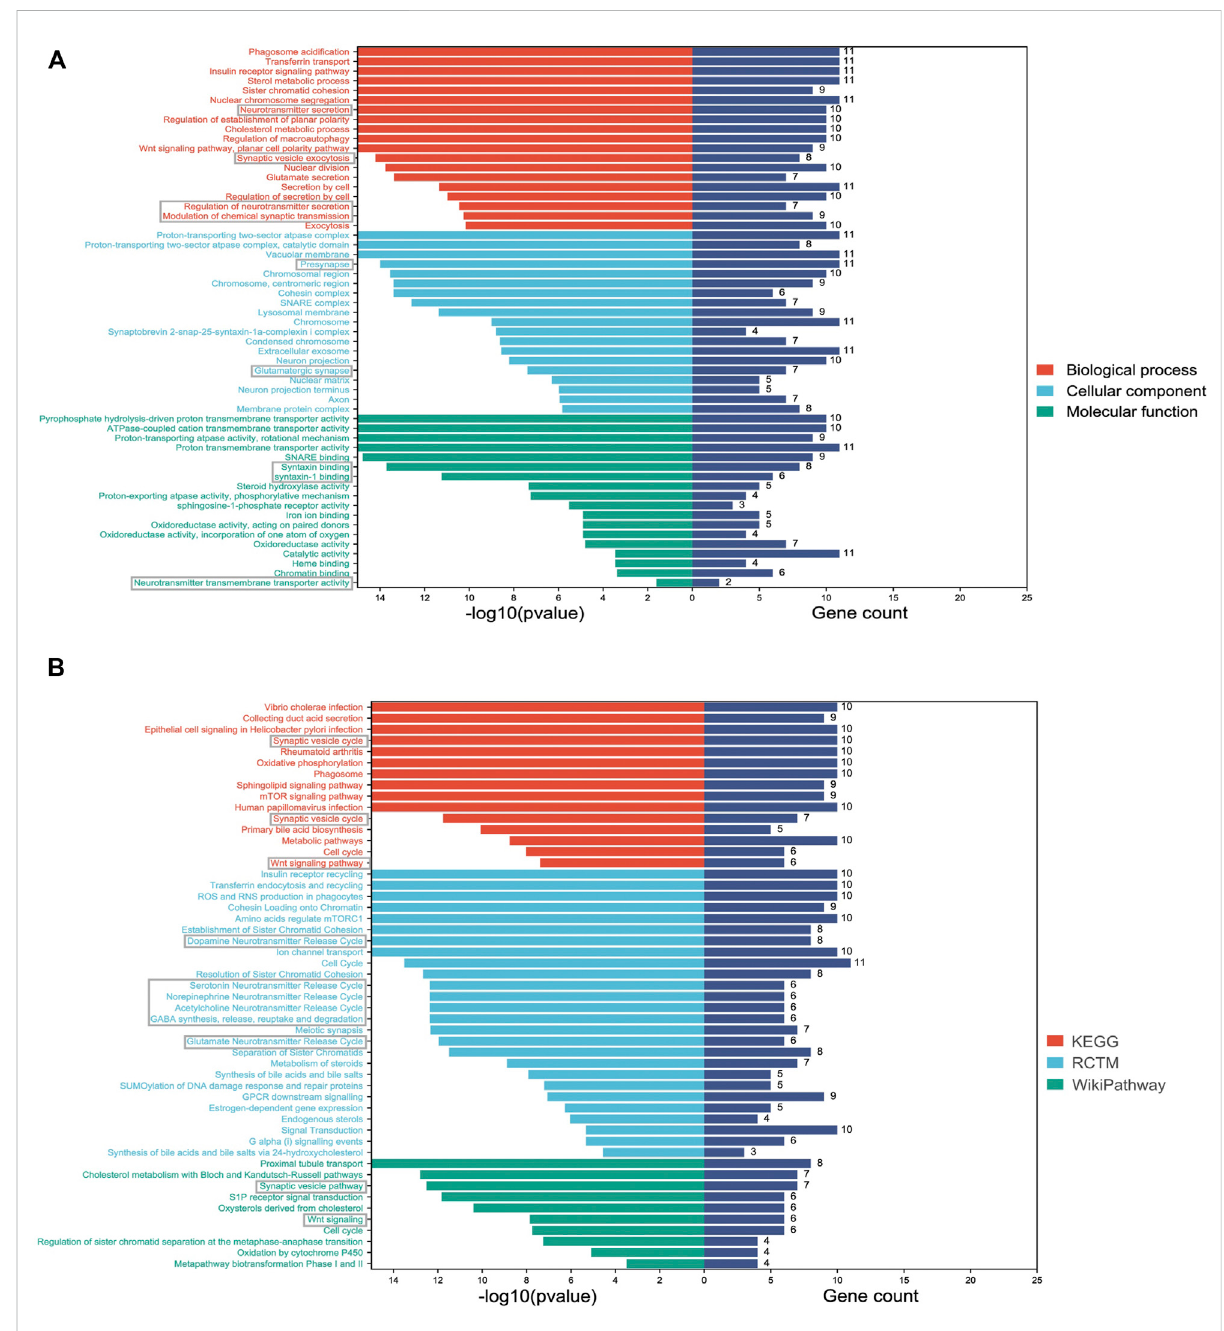
FIGURE 3 Signi fi cantly enriched GO and pathway terms of DMP-related genes. (A) The Y -axis represents the GO terms and the X -axis represents the p values and gene count of enrichment; (B) The Y -axis represents the pathway terms and the X -axis represents the p values and gene count of enrichment. Synaptic function and neurotransmitters-related terms are labeled with grey